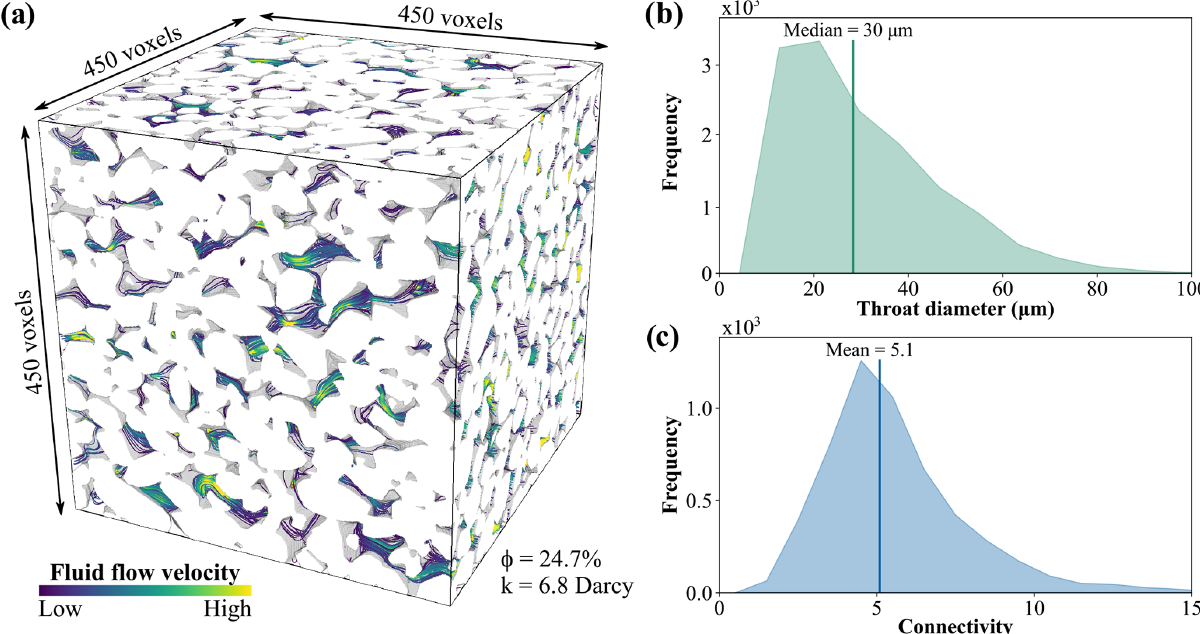
Figure 2. (a) Virtual sample of the unaltered synthetic sandstone including the flow field, represented by streamlines coloured by the local fluid flow velocity. Frequency distribution of the (b) pore throat size and (c) connectivity of the pore network with their respective average